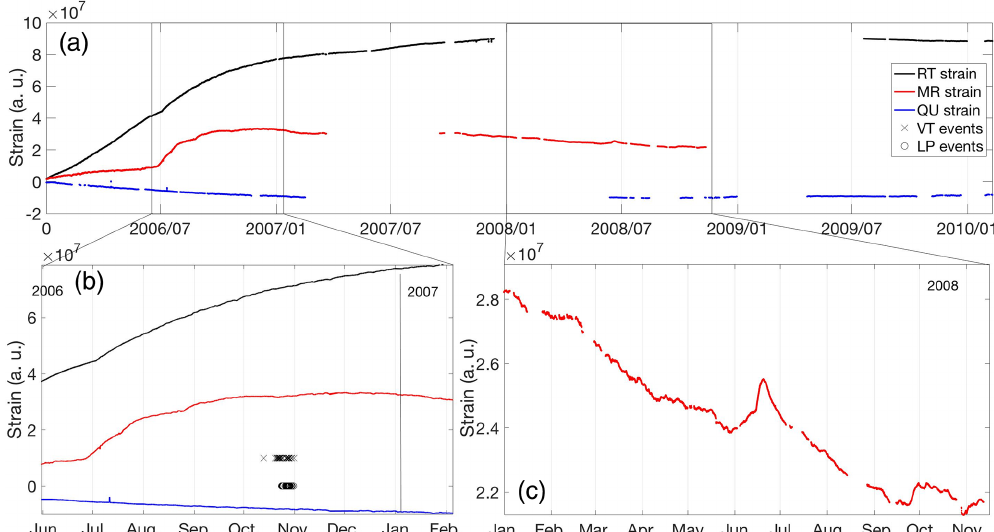
Figure 7. Endogenous events recorded by the three strainmeters. (a) shows the strain recorded by the three strainmeters at RT, MR and QU from January 2006 until March 2010. Strain data are plotted relative to an arbitrary datum. (b) and (c) show a magnified view of the two most significant endogenous events, occurred during 2006 (b) and 2008 (c)